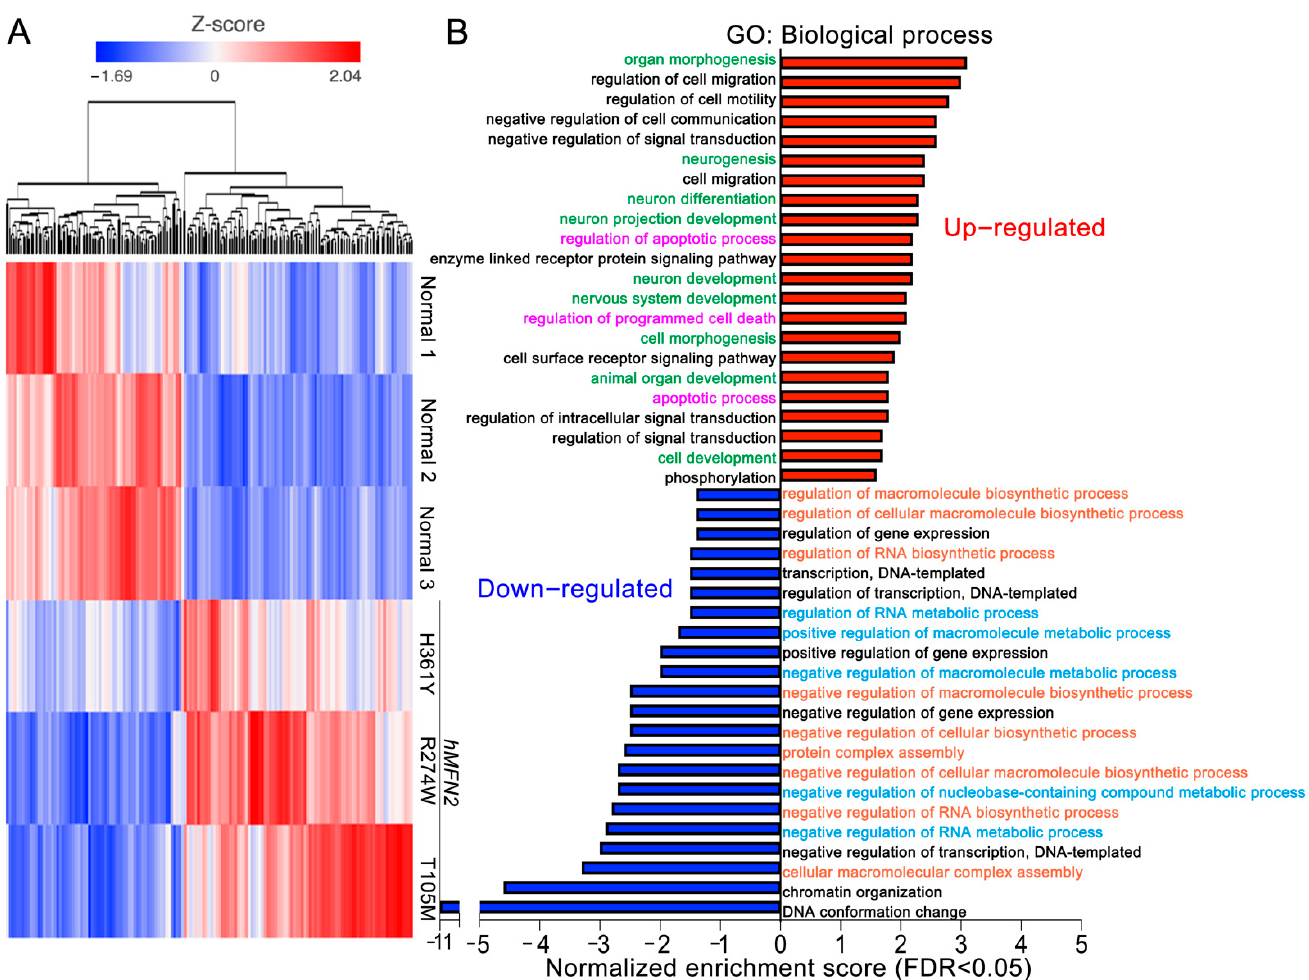
Figure 2. CMT2A patient fibroblasts have a distinct transcriptional signature. ( A ) Heat map results for unsupervised hierarchical clustering of 613 regulated mRNAs; red indicates increased expression, blue indicates decreased expression. mRNA counts in CMT2A vs. normal cells were pre-filtered for CPM ≥ 10 in at least one sample, fold change > ( ± ) 1.5, p < 0.05. ( B ) Gene ontology analysis of the top 100 up- (red) and down- (blue) regulated mRNAs. Same color text indicates common pathways.